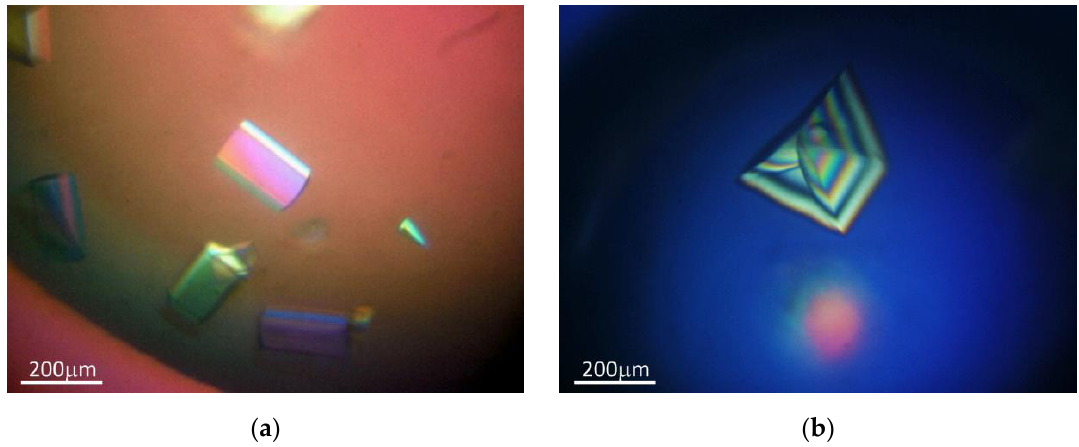
Figure 2. Obtained crystals of: ( a ) an overhanging duplex with Zn 2+ ; ( b ) a blunt-ended duplex.